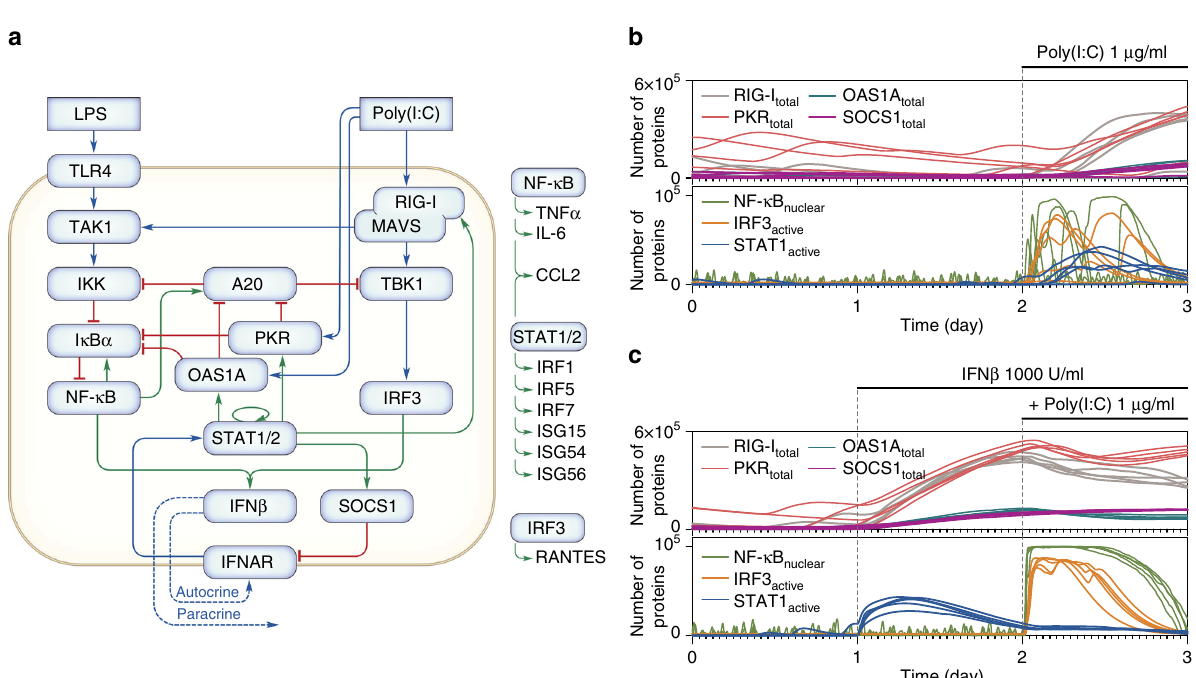
Fig. 6 Mathematical model: analysis of the effect of IFN β pre-stimulation on responses to poly(I:C). a Network diagram. The components of the model which do not in fl uence other components are listed next to the diagram. Blue arrow-headed lines = activation, red hammer-headed lines = inhibition, green arrow-headed lines = positive regulation of transcription. b , c The three-day long stochastic simulations are preceded by 3 × 10 6 s (~35 days) of stochastic equilibration phase (not shown) rendering different values of model variables at time = 0 for the 5 trajectories shown in each panel. b After 2 days of quiescence, WT MEFs were stimulated with 1 μ g/ml poly(I:C) for 1 day. c After 1 day of quiescence, WT MEFs were prestimulated with 1000 U/ml IFN β for 1 day, followed by 1 day stimulation with 1 μ g/ml